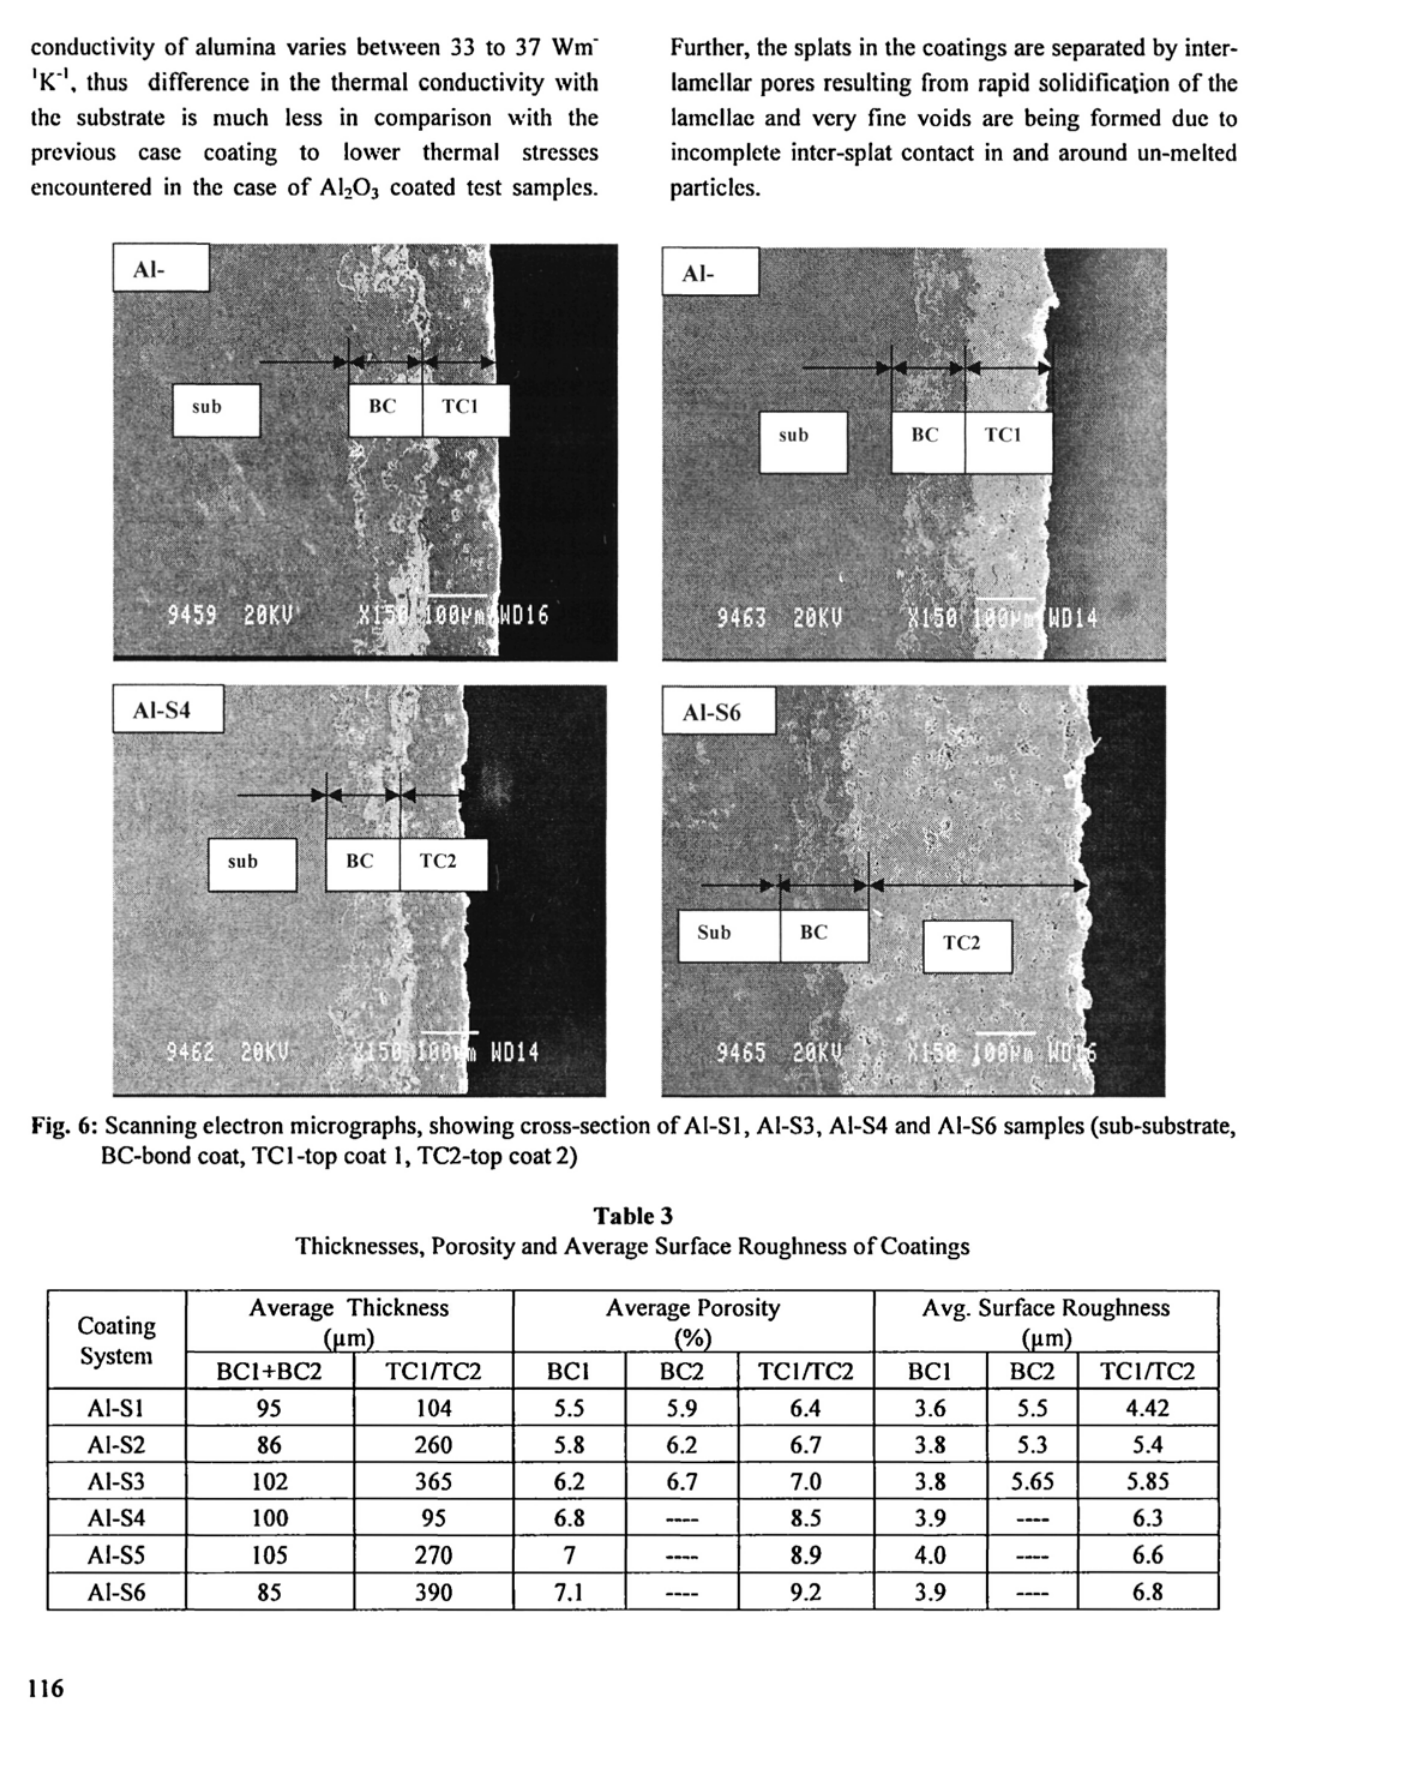
Thicknesses, Porosity and Average Surface Roughness of